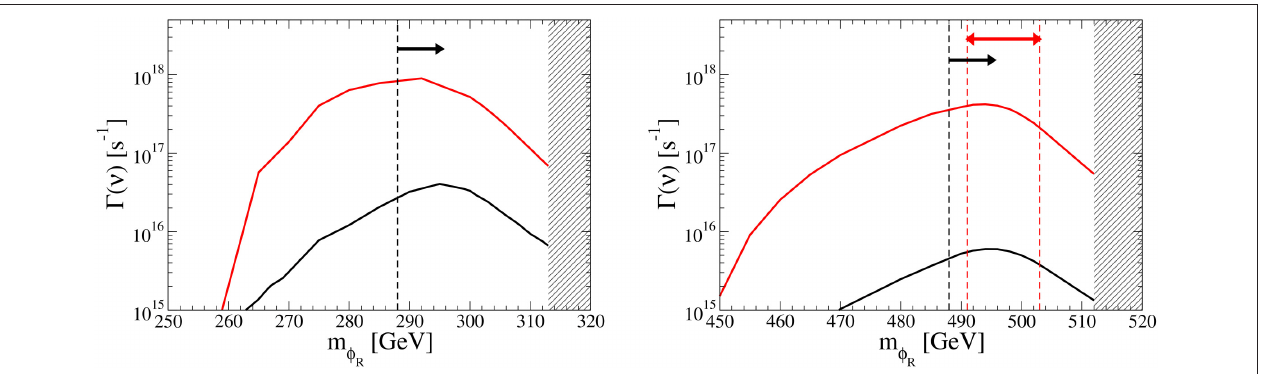
N ν t 0 ) in the Sun against the φ R DM mass for M 1 Ŵ ( φ R χ = → ;